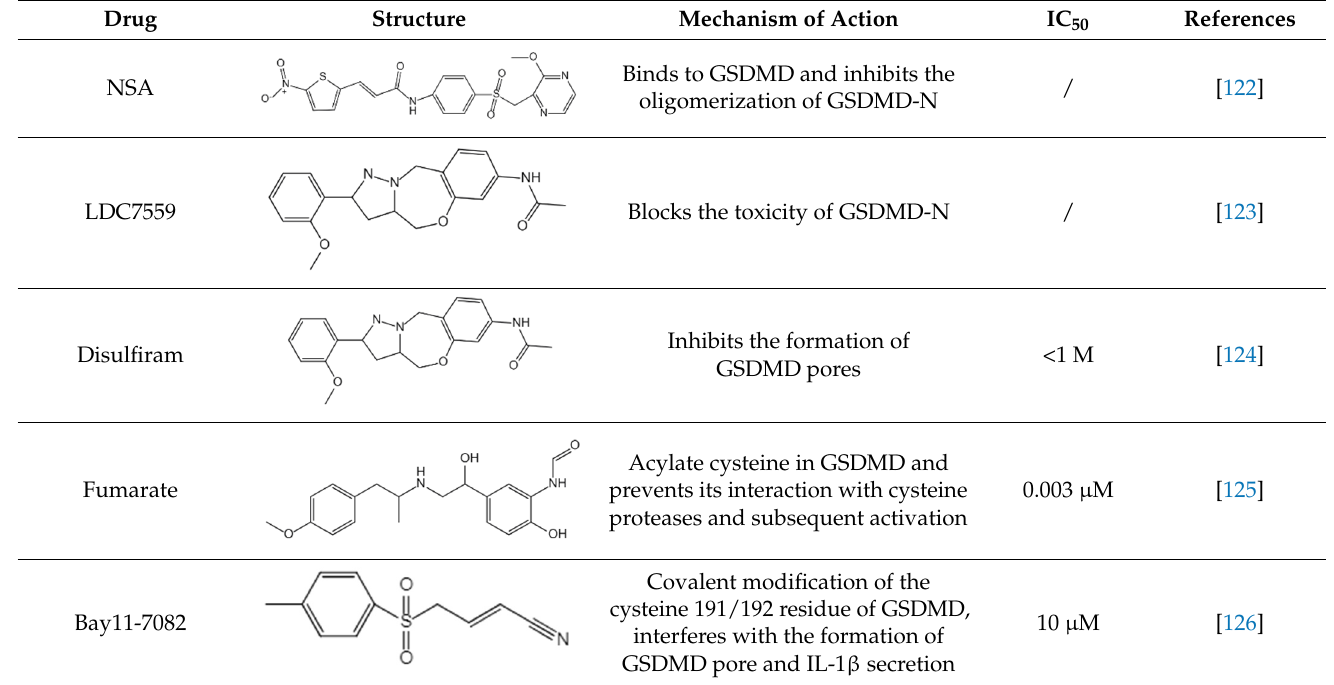
Table 3. Pyroptotic inhibitors targeted to GSDMD.